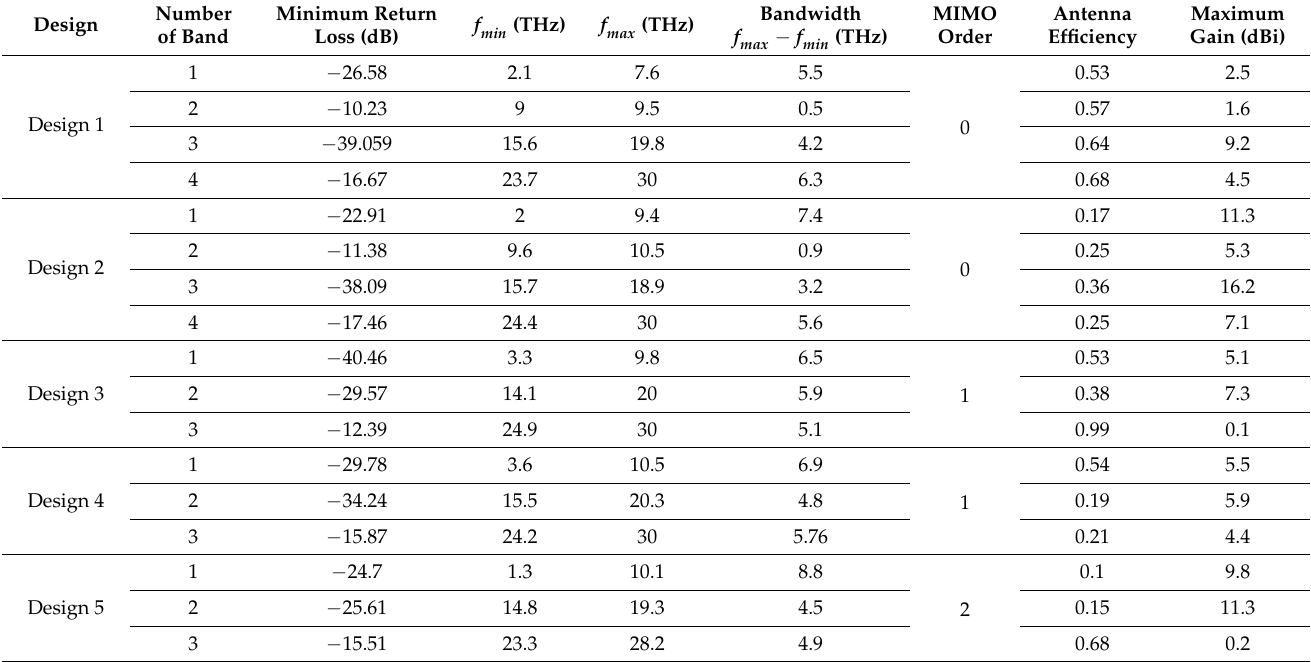
Table 3. Comparative analysis of all the designs regarding return loss, number of operating bands, and